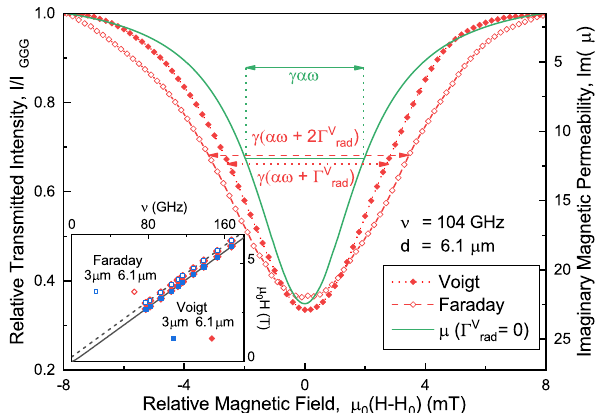
Fig. 2 Ferrimagnetic resonance linewidth in yttrium-iron-garnet (YIG) at ν = 104 GHz frequency. Resonance curves show the γαω intrinsic damping in the imaginary part of the magnetic permeability (Im ð μ Þ , green, on the inverse scale of the right axis) together with the observed transmission in the Faraday (magnetic fi eld parallel to light propagation direction, red open diamonds) and Voigt (magnetic fi eld perpendicular to light propagation direction, red fi lled diamonds) geometries. In the latter cases, the further line broadening is attributed to the radiative damping, Γ V . γ , α , and ω stand rad for the gyromagnetic ratio, the dimensionless intrinsic damping rate, and the angular frequency, respectively. The horizontal axis shows the magnetic fi eld H relative to the corresponding resonance fi eld H 0 . Labels on the left vertical axis belong to the experimental curves and indicate the transmitted light intensity I relative to the gadolinium-gallium-garnet (GGG) substrate ’ s transmission baseline I GGG , which can be measured without the YIG layer. The frequency dependences of the ferrimagnetic resonance fi elds (open/ fi lled symbols for Faraday/Voigt geometry experiments) in two YIG fi lms of different thicknesses (blue squares for d = 3 μ m and red diamonds for d = 6.1 μ m) are presented in the inset, where dashed/solid lines show theoretical expectations of the resonance frequencies for Faraday/Voigt geometry. On the scale of the inset, symbols corresponding to the two samples at a given frequency are completely superposed and are bigger than the corresponding error